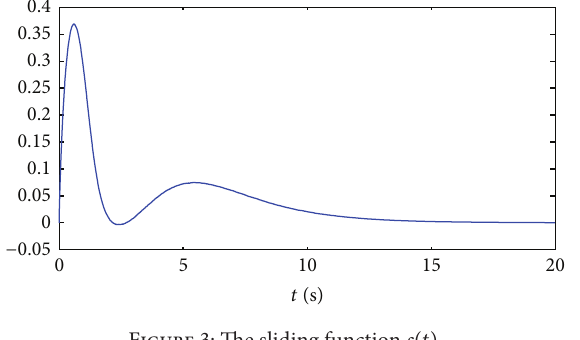
Figure 3: The sliding function 𝑠(𝑡) .